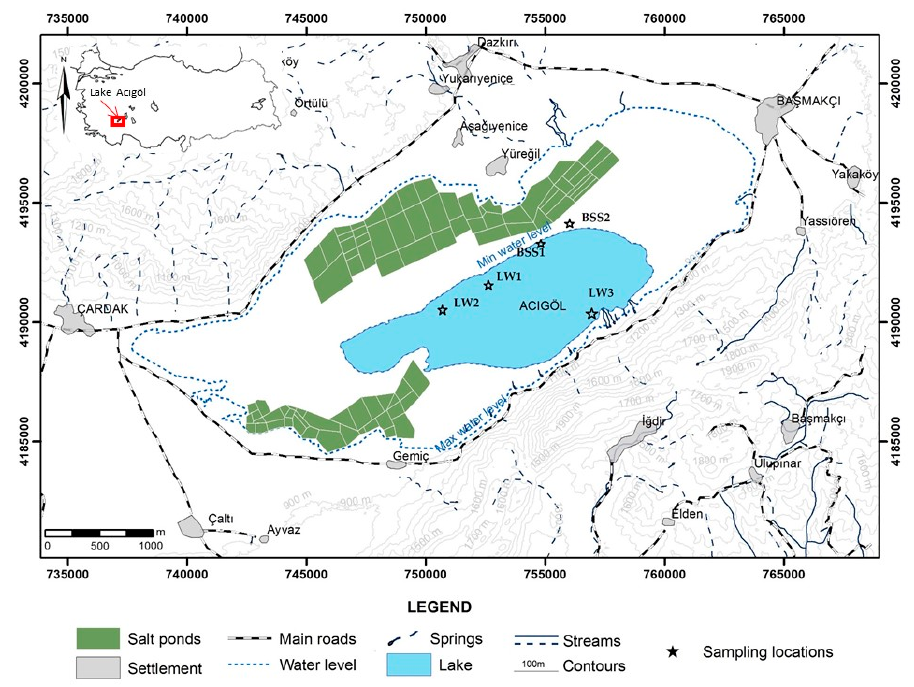
Table 1. Physico-chemical characteristics of the lake and the saltern ponds water overlying the sampled sediments.